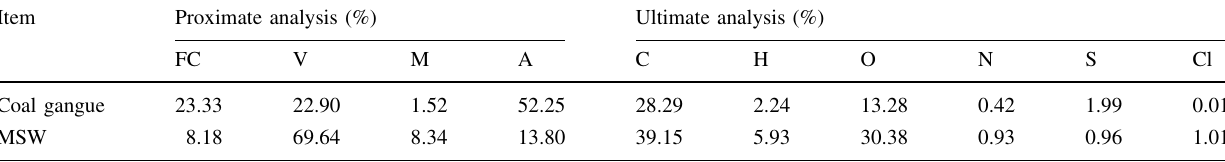
Table 1 Proximate and ultimate analysis of coal gangue and MSW (received basis)